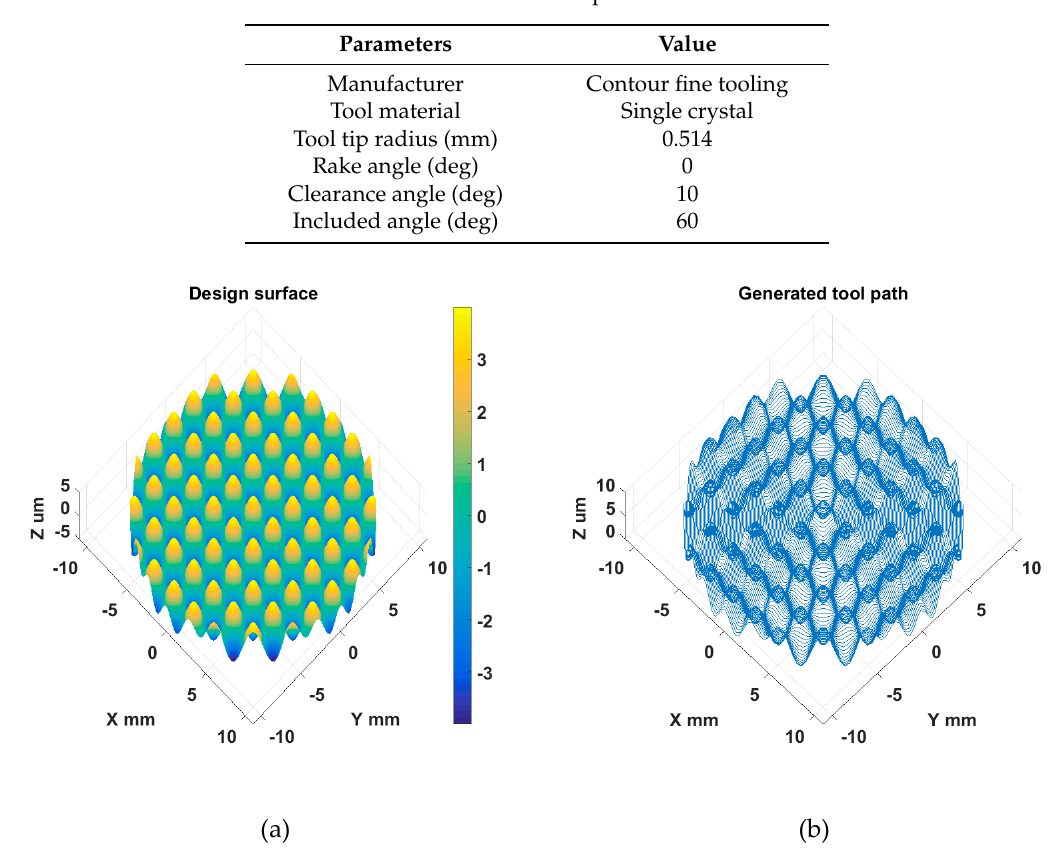
Figure 19. ( a ) Design and ( b ) STS tool path of sinusoidal grid surface.